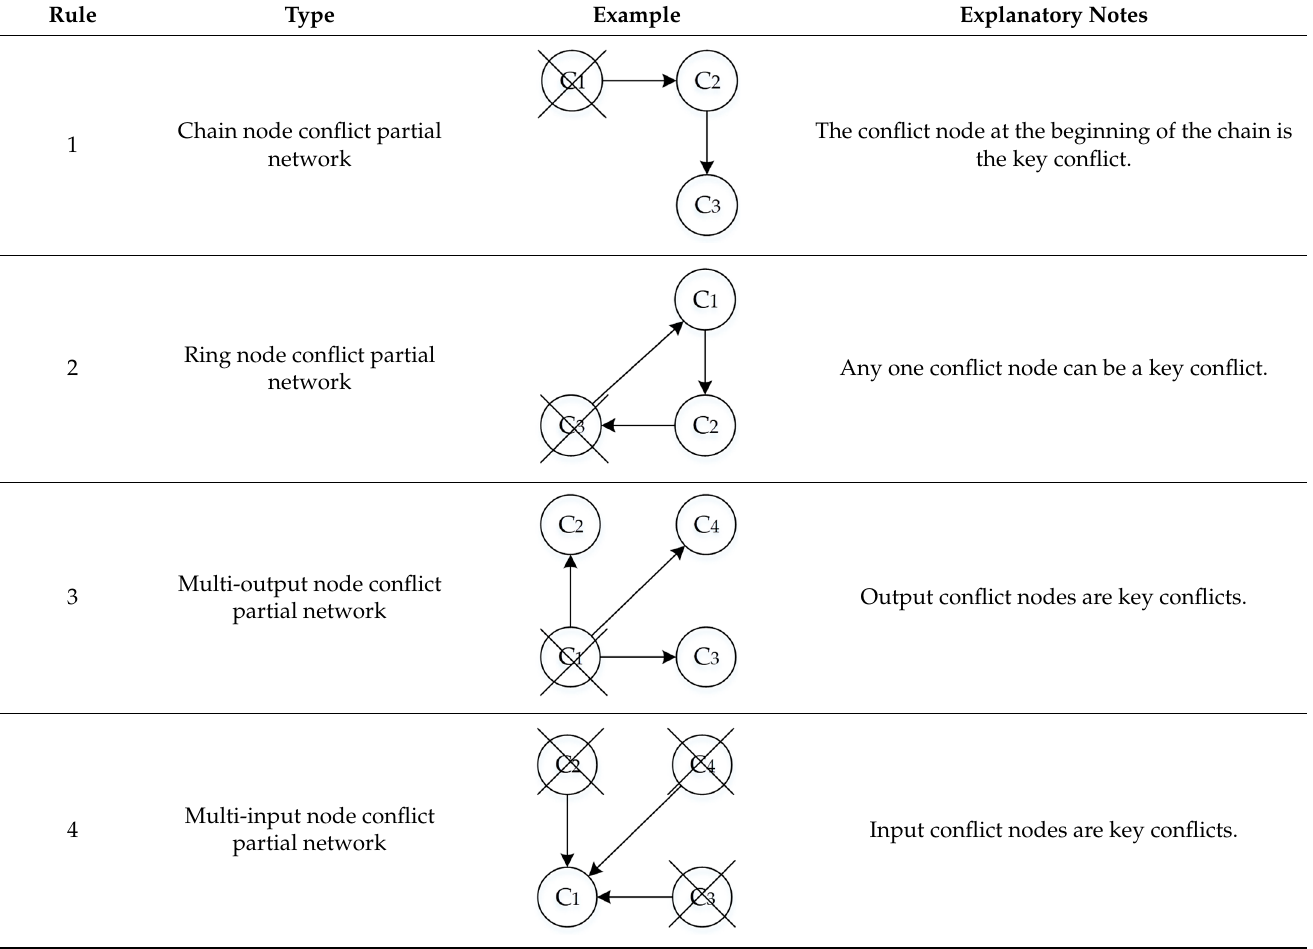
Table 1. Node conflict network simplified rules.